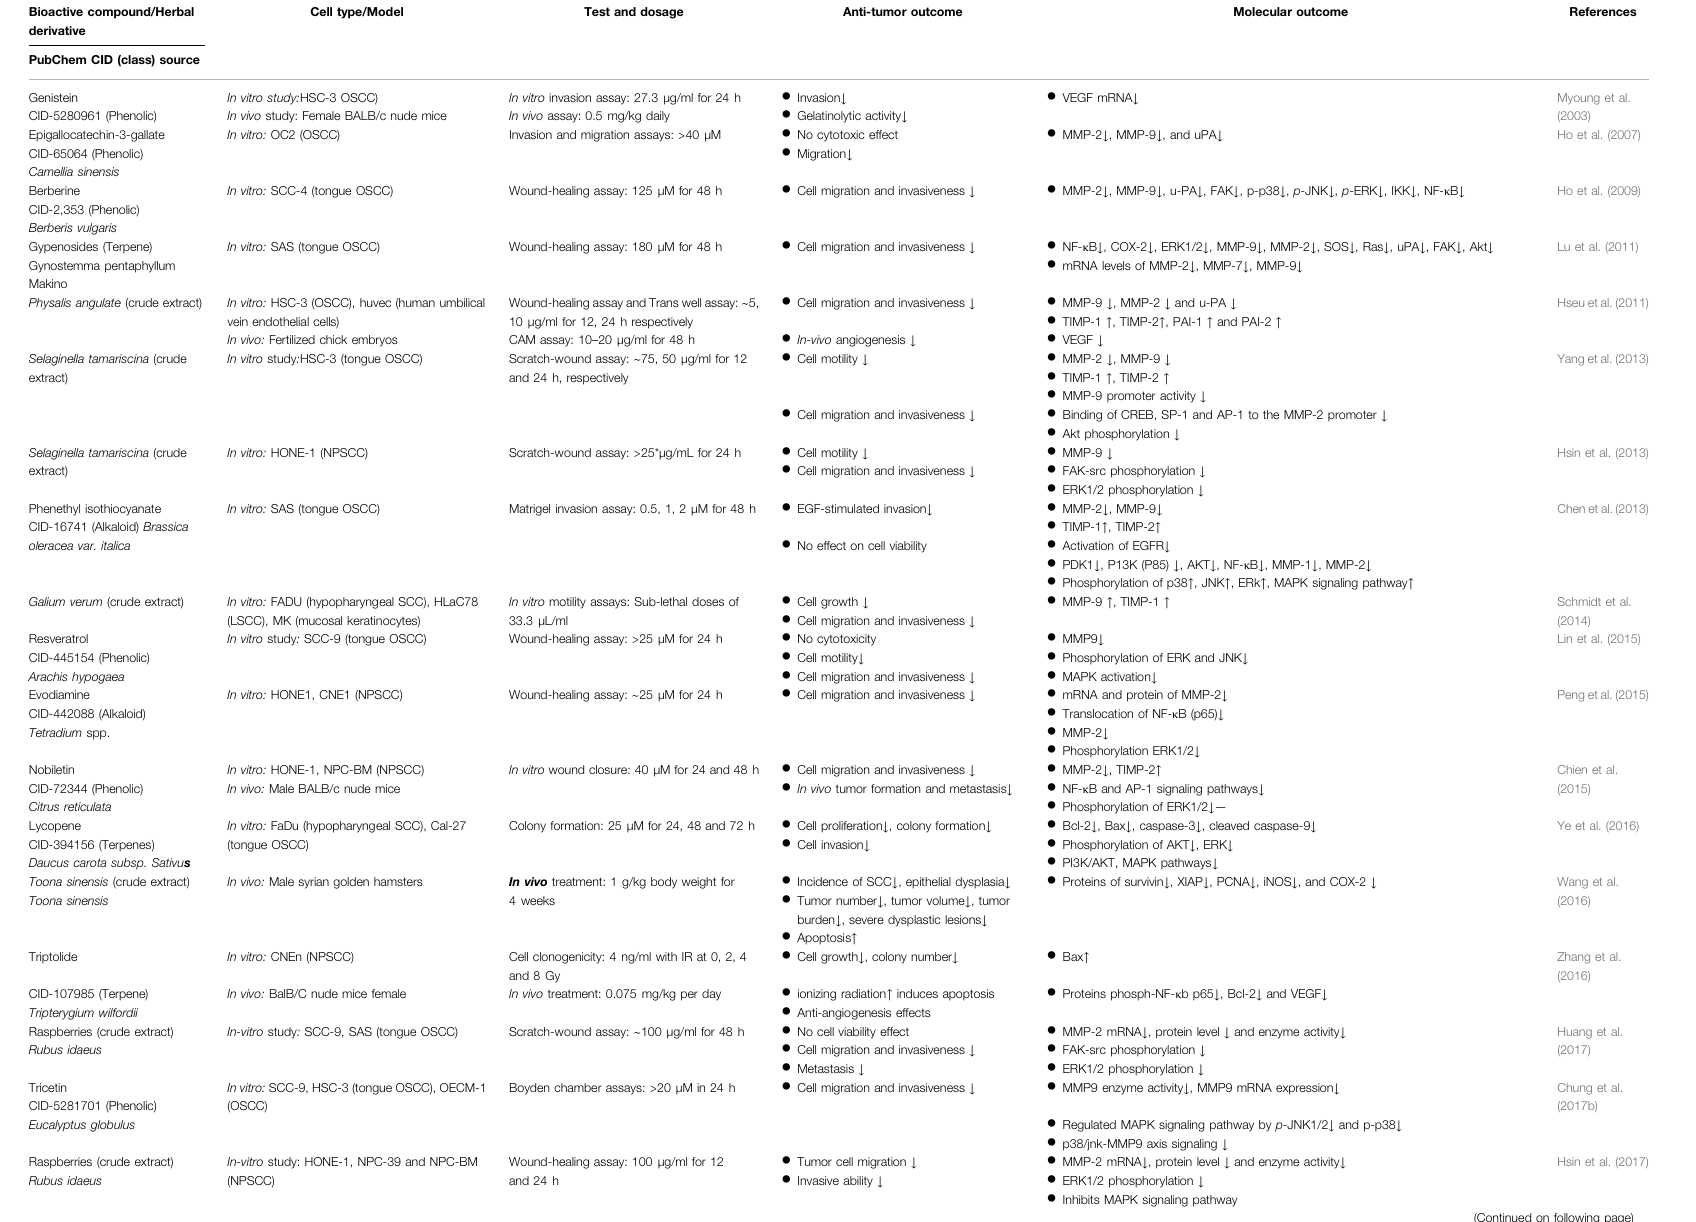
TABLE 6 | Pre-clinical studies in emerging chemopreventive phytochemicals/herbal derivatives against HNC. Bioactive compound/Herbal